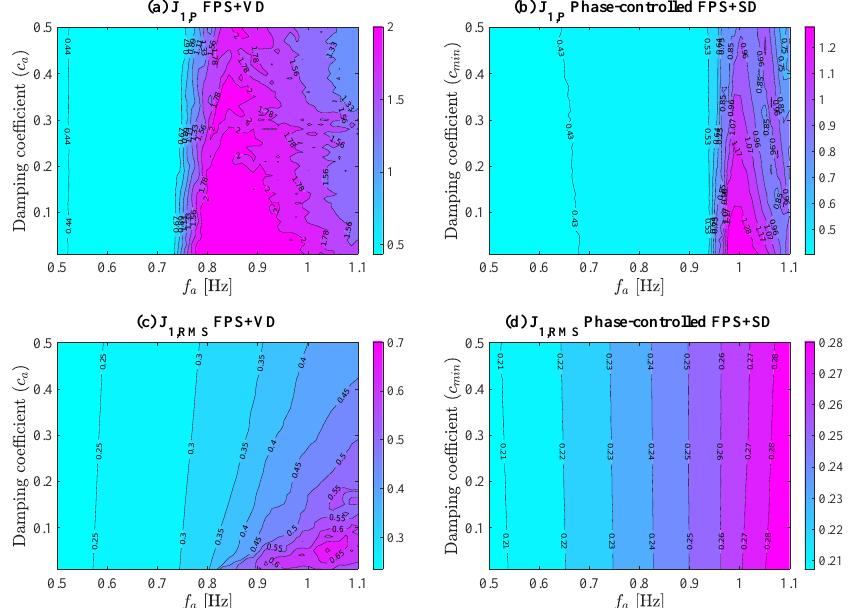
Figure 10. J 1 for FPS+VD and phase-controlled FPS+SD under the design earthquake.